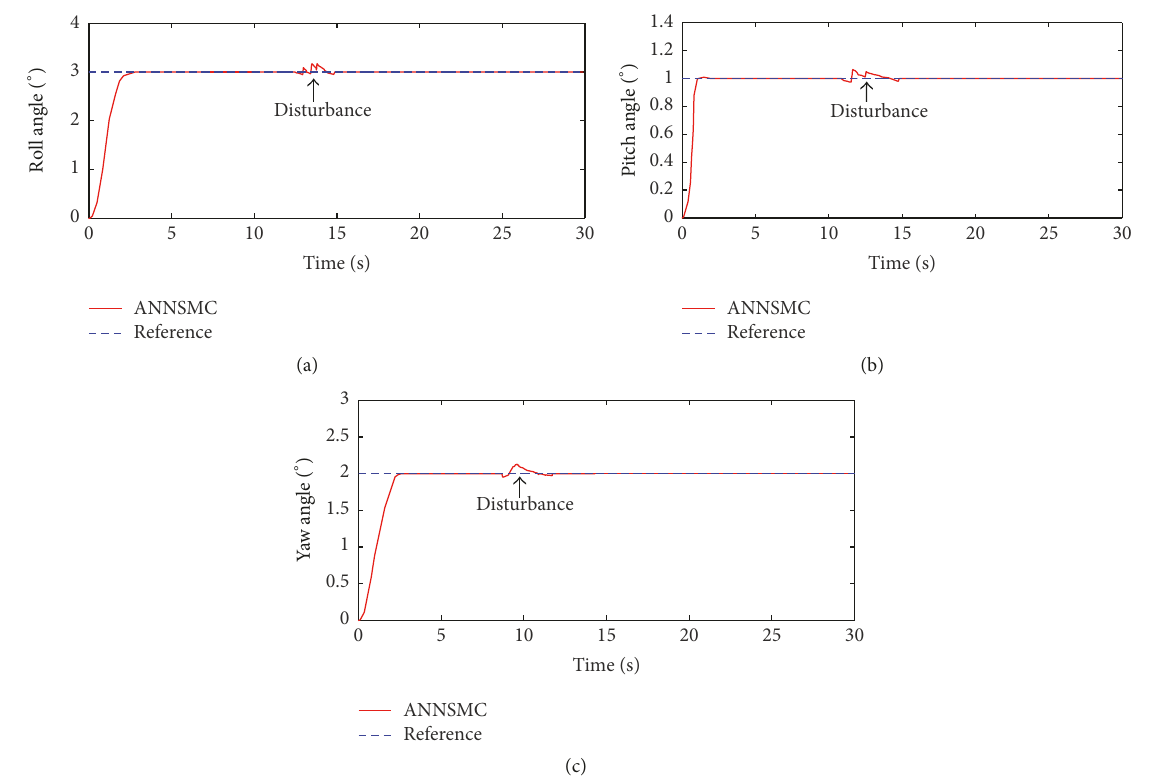
Figure 9: Helicopter attitude behavior response to the step signal with external disturbances.